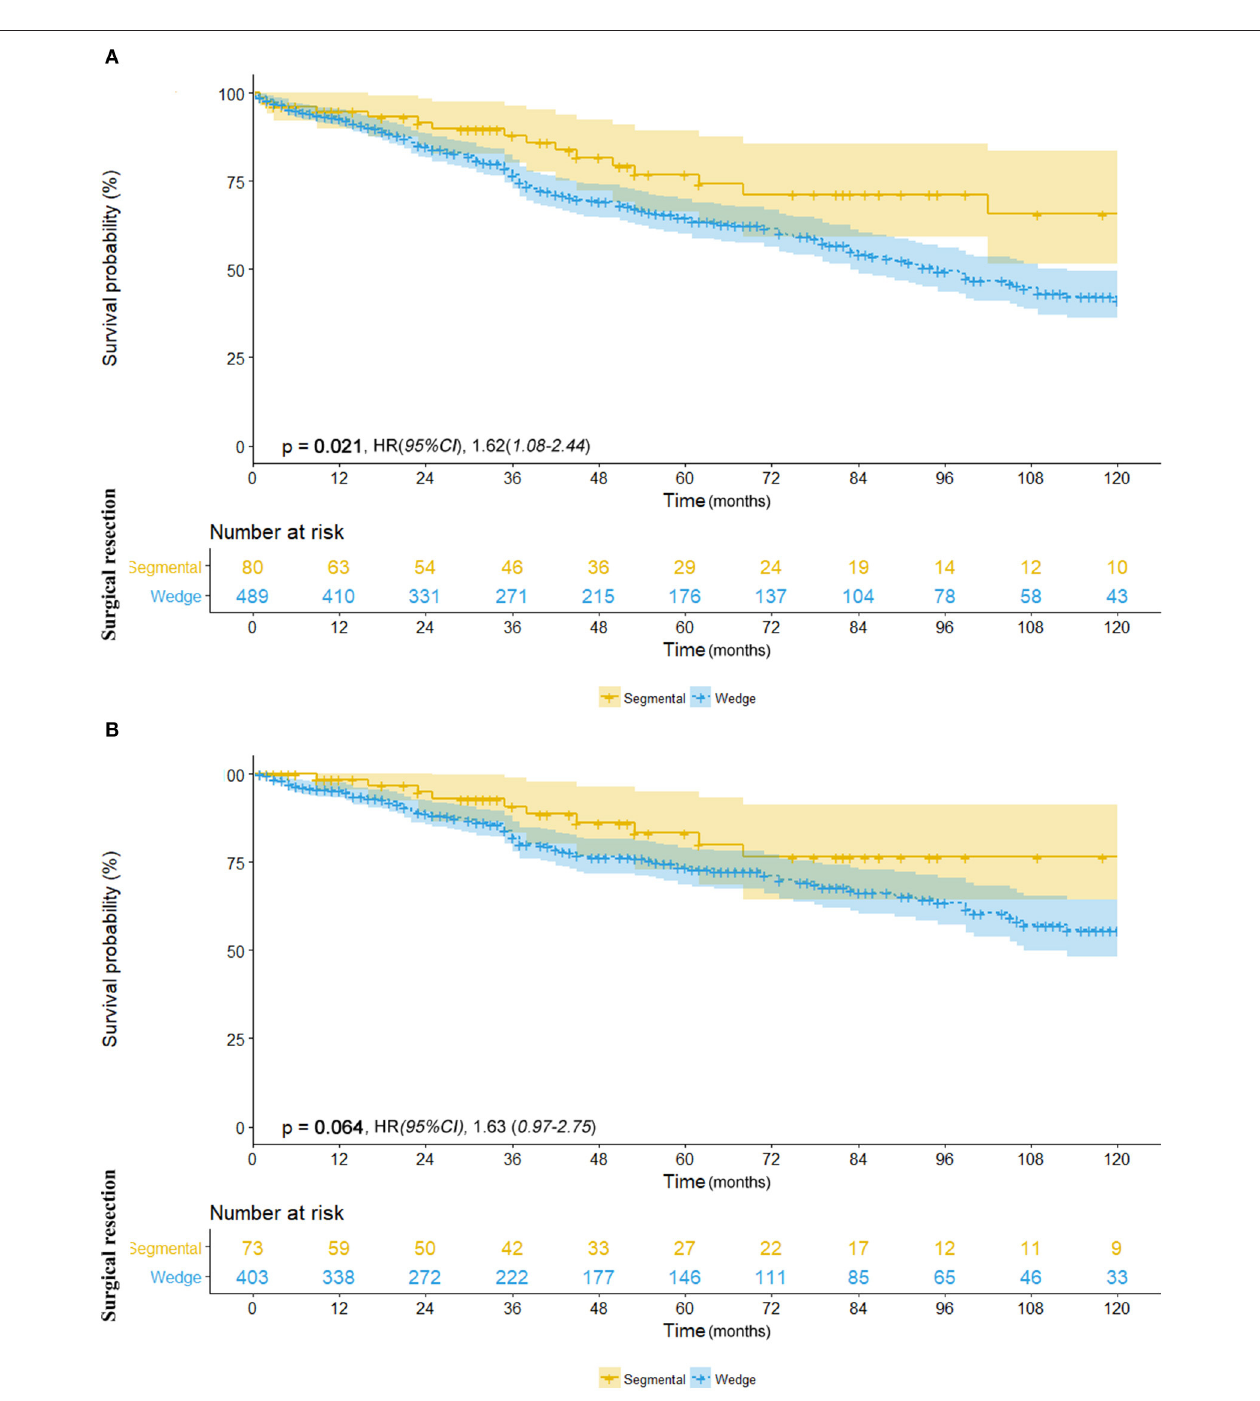
FIGURE 3 | (A) Overall survival in patients with NSCLC ≤ 8mm who underwent segmentectomy (yellow line) vs. wedge resection (blue line). (B) Cancer-specific survival in patients with NSCLC ≤ 8mm who underwent segmentectomy (yellow line) vs. wedge resection (blue line).